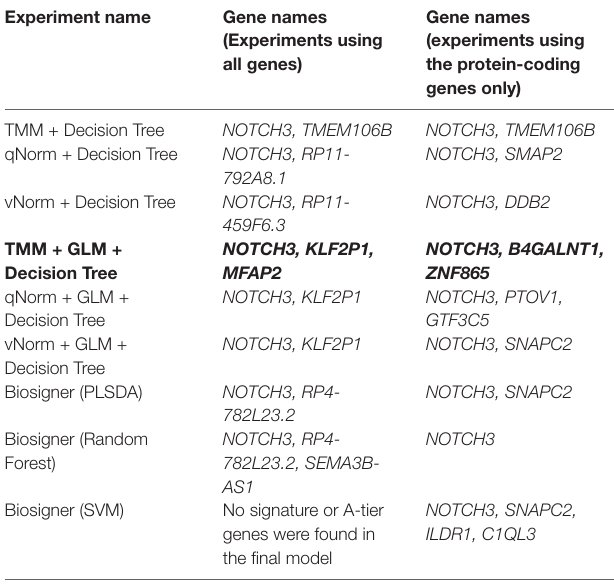
TABLE 4 | Candidate biomarker genes from transcriptomics analysis.